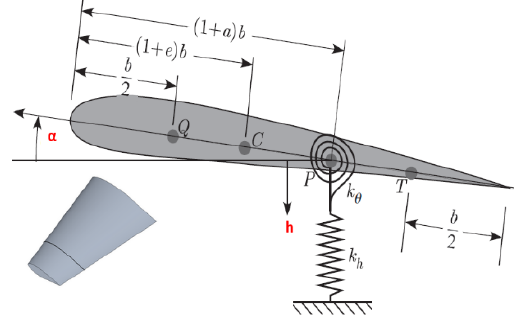
Figure 2. Flutter binary